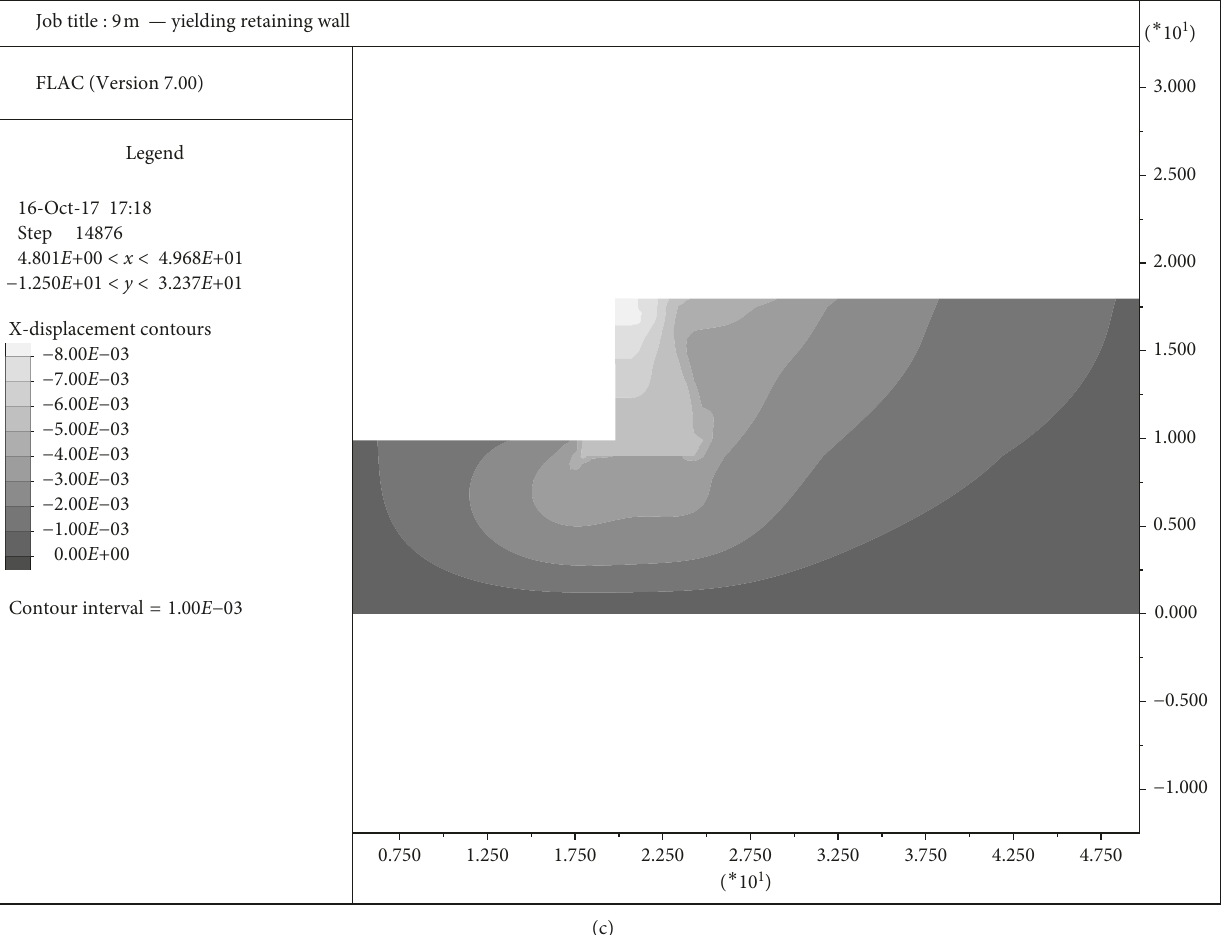
Figure 2: Horizontal displacement contours for yielding retaining walls: (a) H